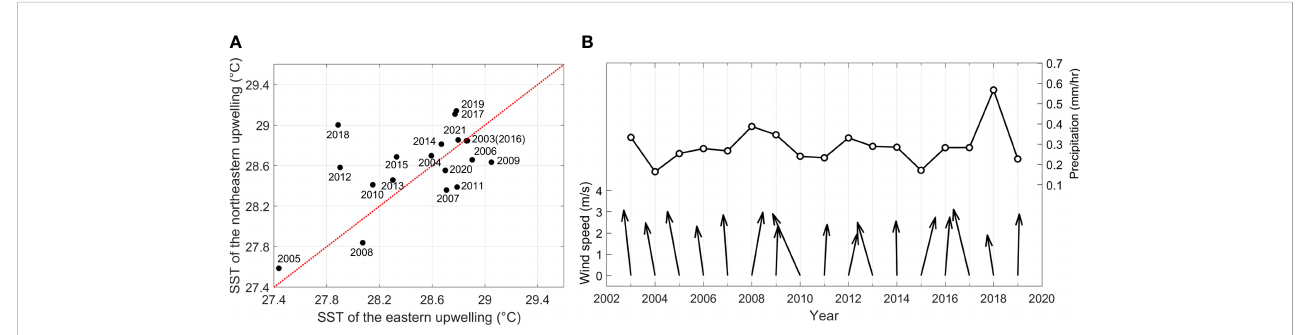
FIGURE 7 Relationship between sea surface temperature in the east upwelling and northeast upwelling (A) and interannual variations of precipitation and wind speed in the northeast upwelling region (B)